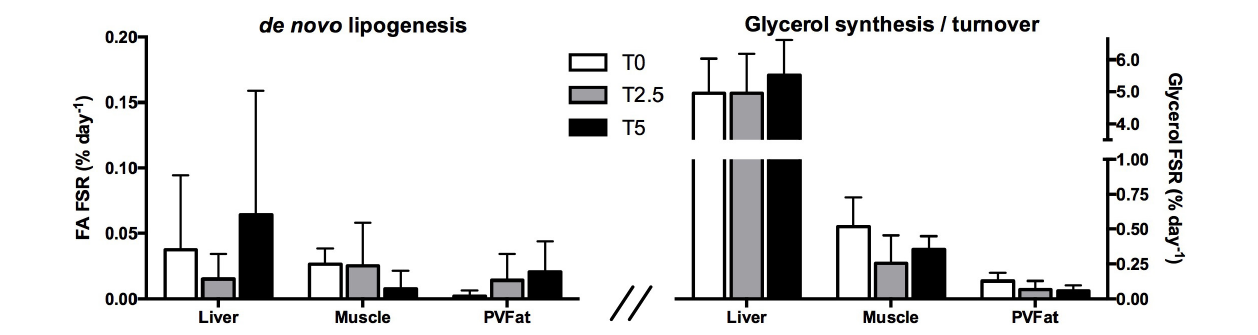
FIGURE 2 | TAG-bound fatty acid fractional synthetic rate (FA FSR; de novo lipogenesis ) expressed as percent of newly synthesized fatty acids per day (left) and TAG-bound glycerol fractional synthetic rate (Glycerol FSR; glycerol synthesis/turnover) expressed as percent of newly synthesized/turned over glycerol per day in hepatic, muscular and perivisceral TAG of rainbow trout ( Oncorhynchus mykiss ) fed with different levels of glycerol (0, 2.5, and 5%) after a 6-day residence in a tank with ∼ 4% 2 H-enriched water. Mean values ± SD are presented ( n = 6). Significant differences between dietary treatments are indicated by different letters (one-way ANOVA, p < 0.05; followed by Tukey’s